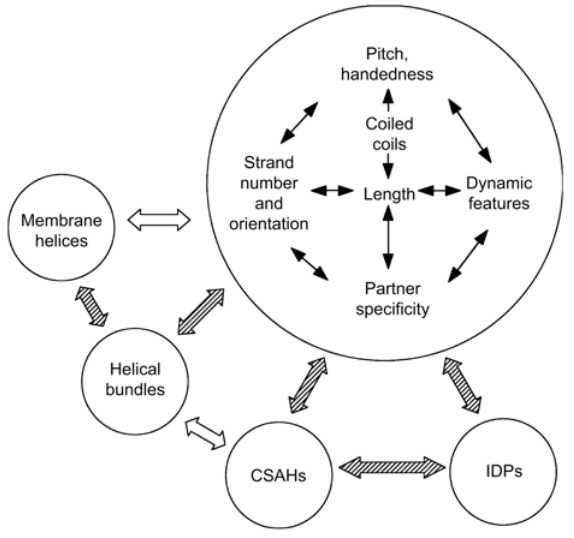
Figure 6 A possible depiction of suggested interrelationships of coiled coil features as well as coiled coils and other structural motifs in the course of protein structural evolution. Routes that might be less prevalent are shown with hollow